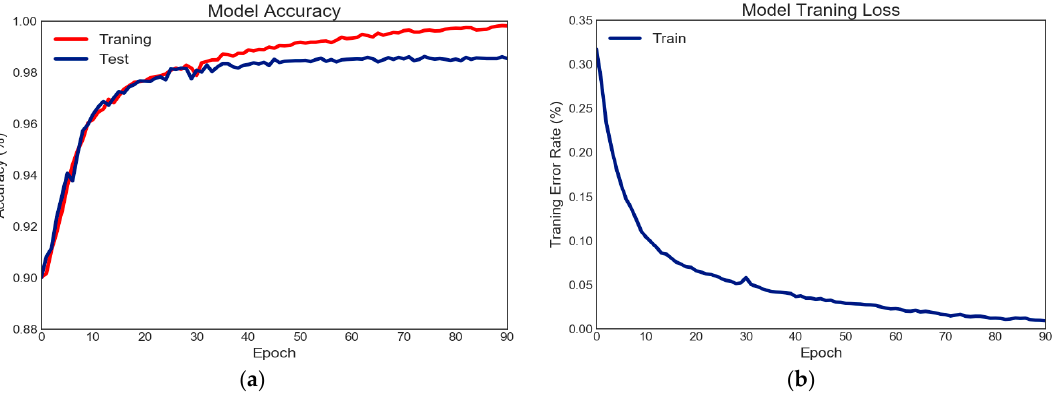
Figure 6. ( a ) Accuracy on the CMATERDB 3.3.1 dataset; ( b ) Training error rates of RBM–CNN on the CMATERDB 3.3.1 dataset.